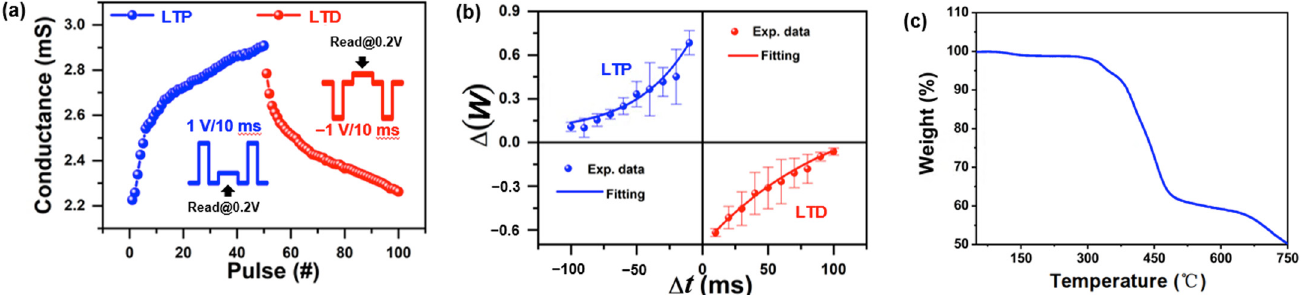
Figure 3. Current–voltage characteristics of the Ta/EV(ClO 4 ) 2 /BFPA-F/Pt memristor when subjected to ( a ) consecutive positive voltage sweeps (0 V → 1 V → 0 V) and ( b ) consecutive negative voltage sweeps (0 V → − 1 V → 0 V). Small voltages of 0.2 V and − 0.2 V are used to read the positive and negative current responses, respectively.